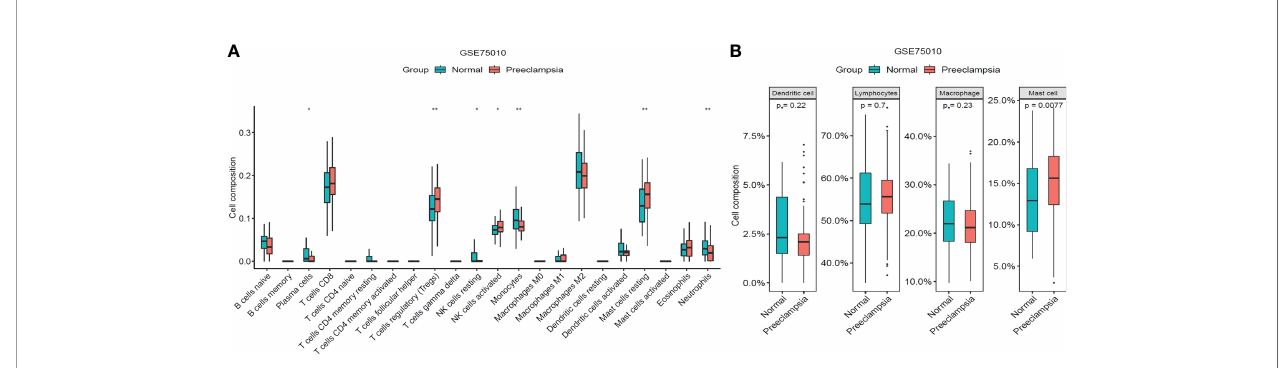
FIGURE 9 | Distribution of immune cells between non-PE group and PE group. (A) Differences of immune cell types between non-PE group and PE group. (B) Differences among total lymphocytes, total dendritic cell, total macrophage and total mast cell between non-PE group and PE group. *P < 0.05, **P <